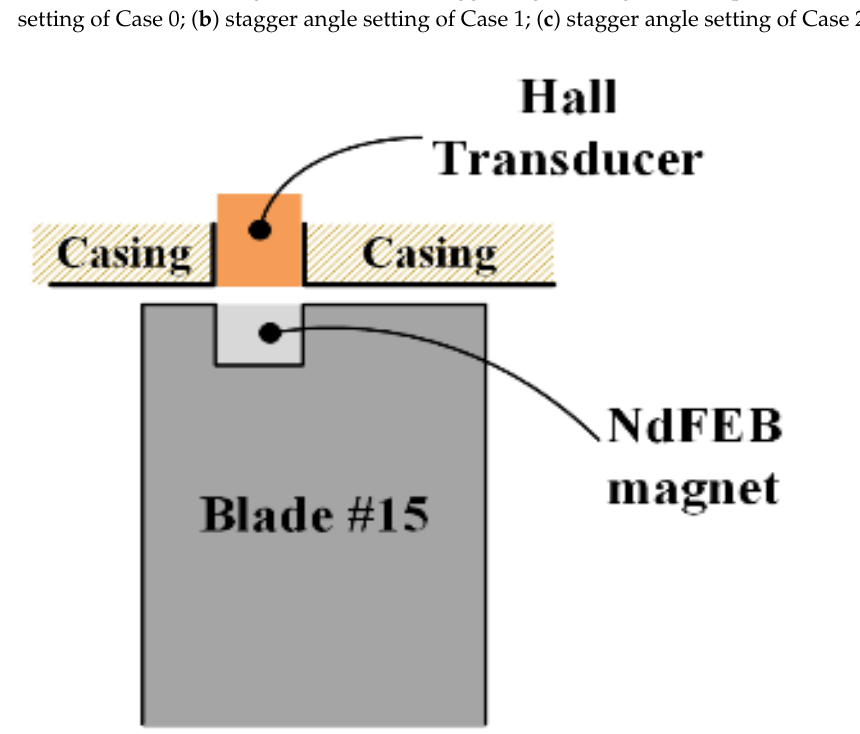
Figure 5. Installation diagram of the Hall transducer and magnet used in phase-locked technology.